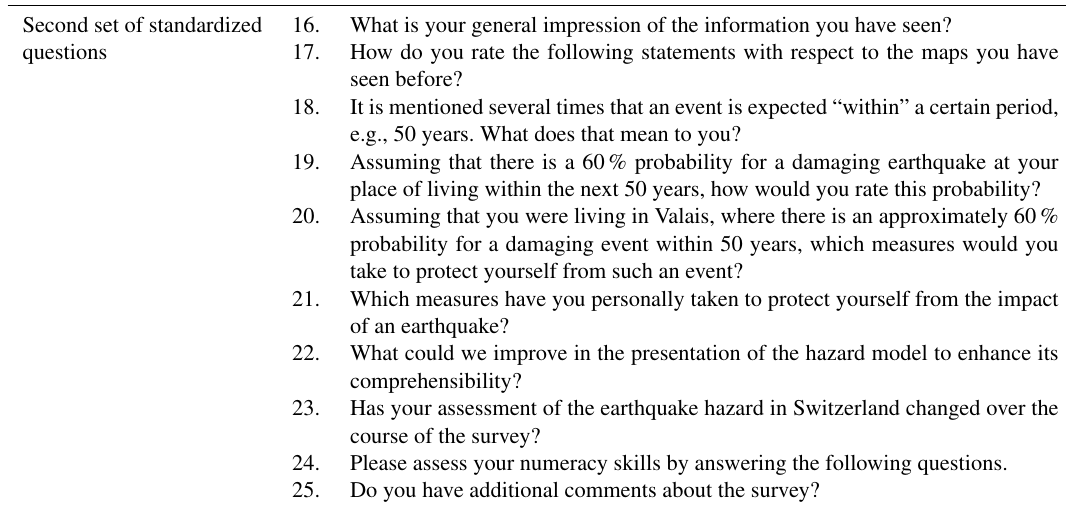
Table 3. Second set of standardized questions. Translated from German to English by the authors. Second set of standardized